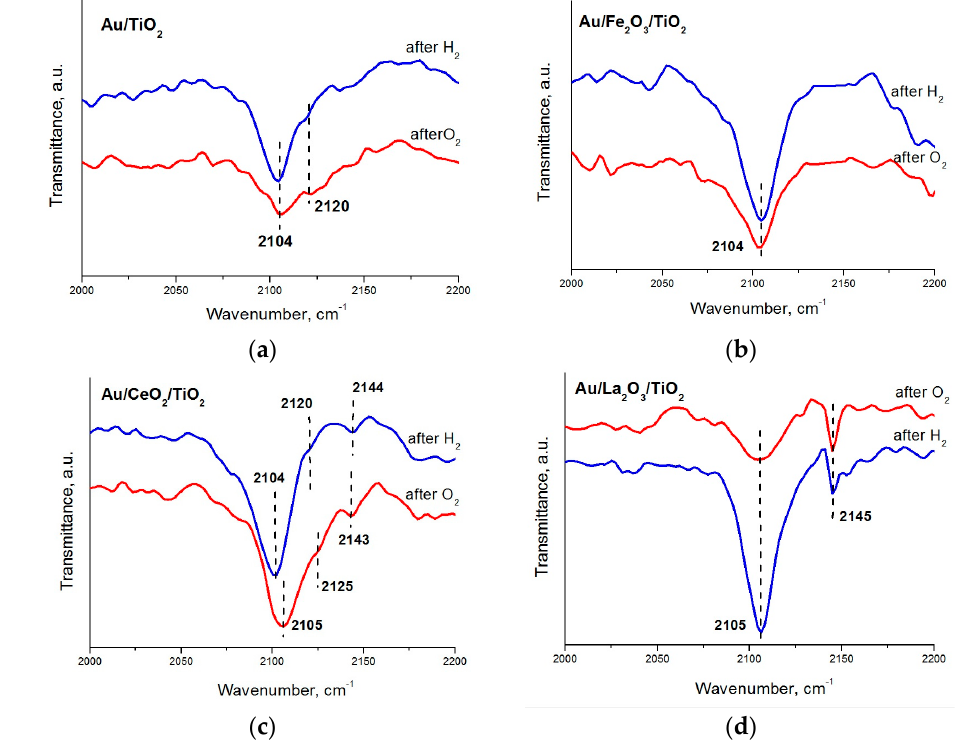
Figure 3. IR spectra of CO adsorbed on Au/TiO 2 ( a ) and Au/M x O y /TiO 2 (M x O y = La 2 O 3 , CeO 2 or Fe 2 O 3 ) ( b – d ) catalysts pretreated at 300 °C for 1 h in hydrogen or oxygen atmosphere.